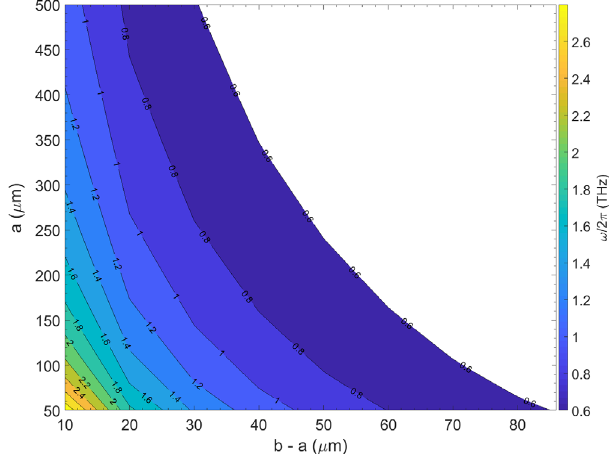
FIG. 3. TM 01 mode frequency dependence on the DLW inner radius a and dielectric thickness b − a